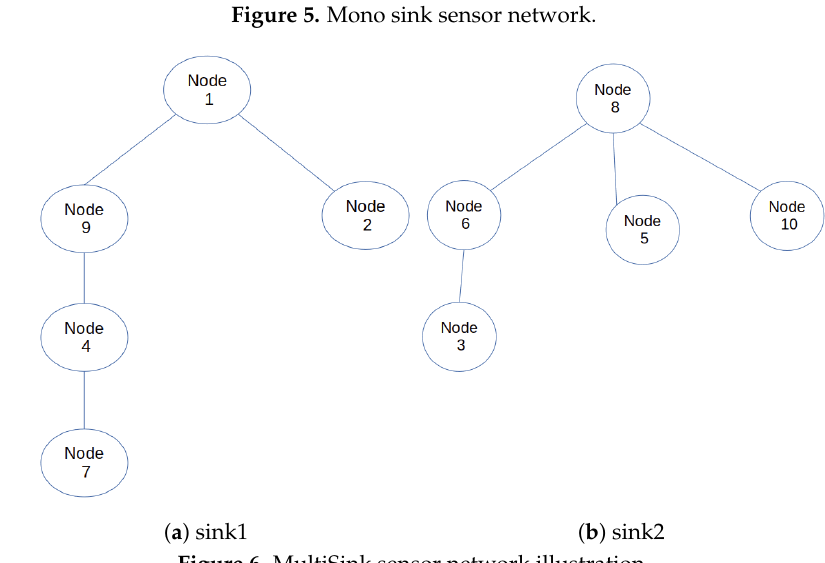
Figure 6. MultiSink sensor network